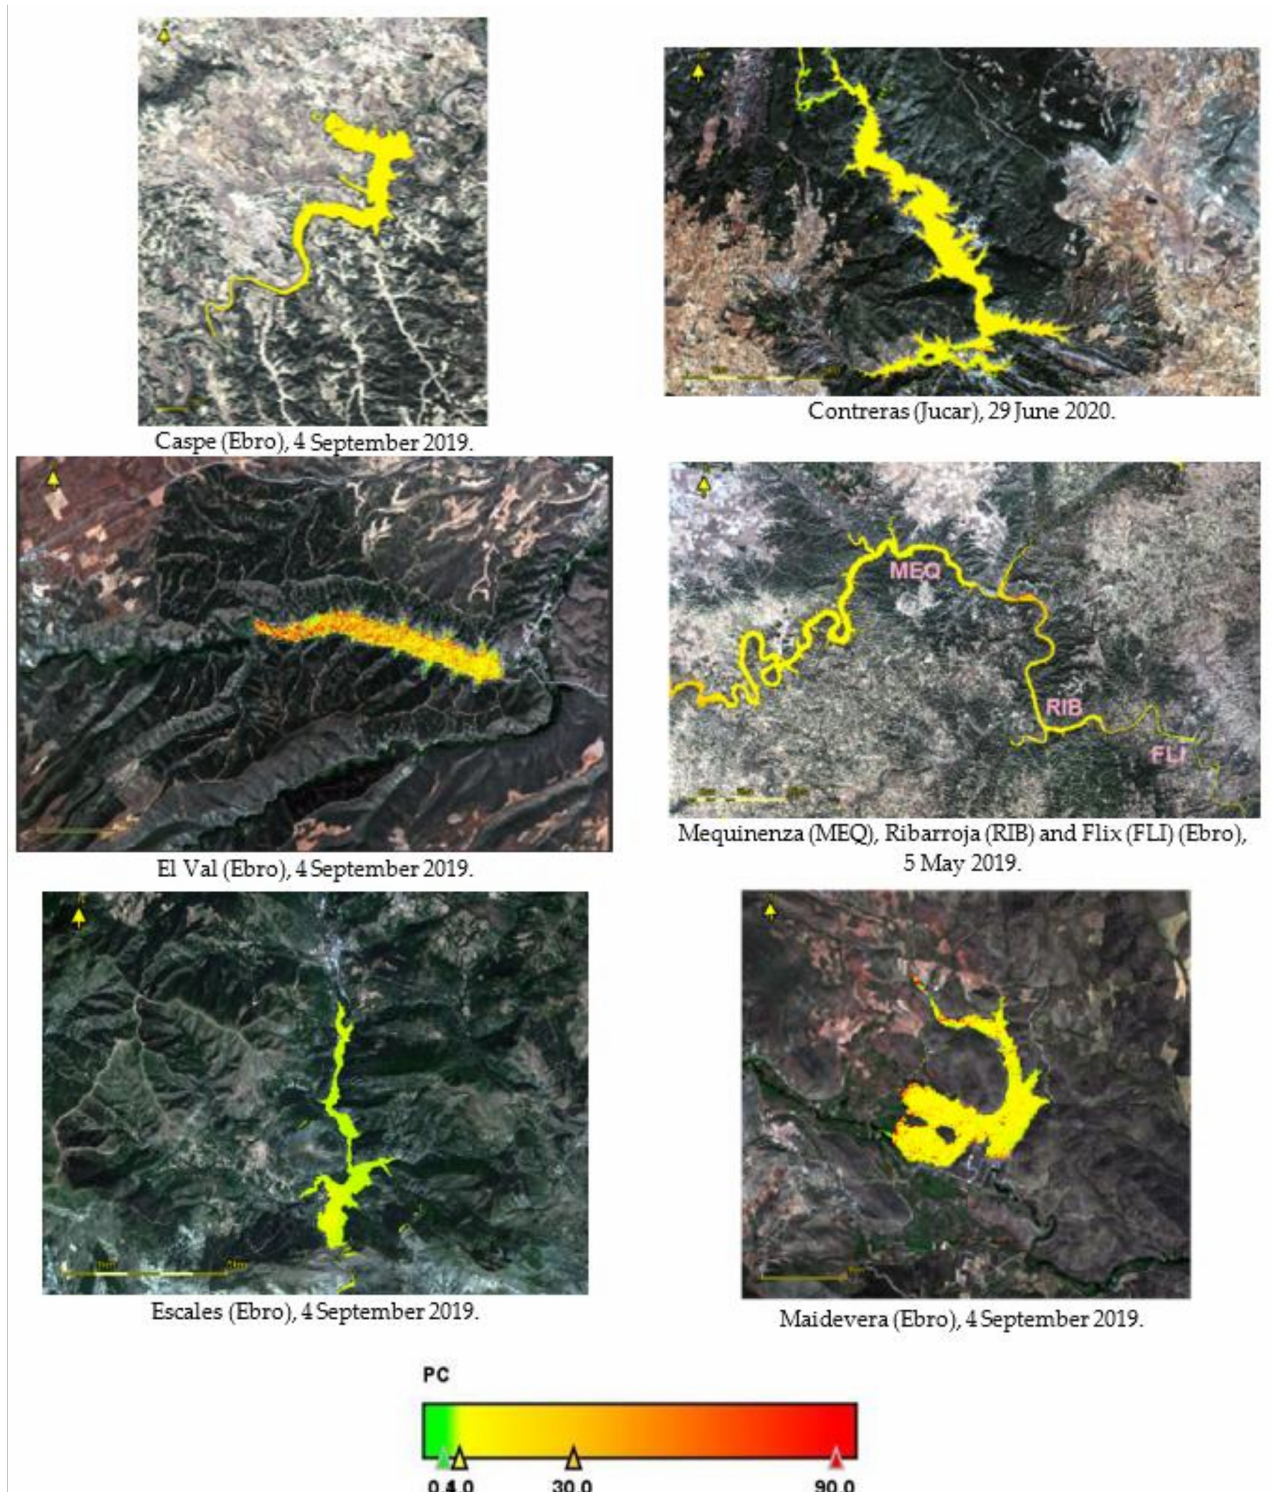
Figure A2. Thematic maps of PC ( µ g L − 1 ) in some reservoirs, showing the alert level in a color scale according to Table 3. For each site, the date of the image and the watersheds are